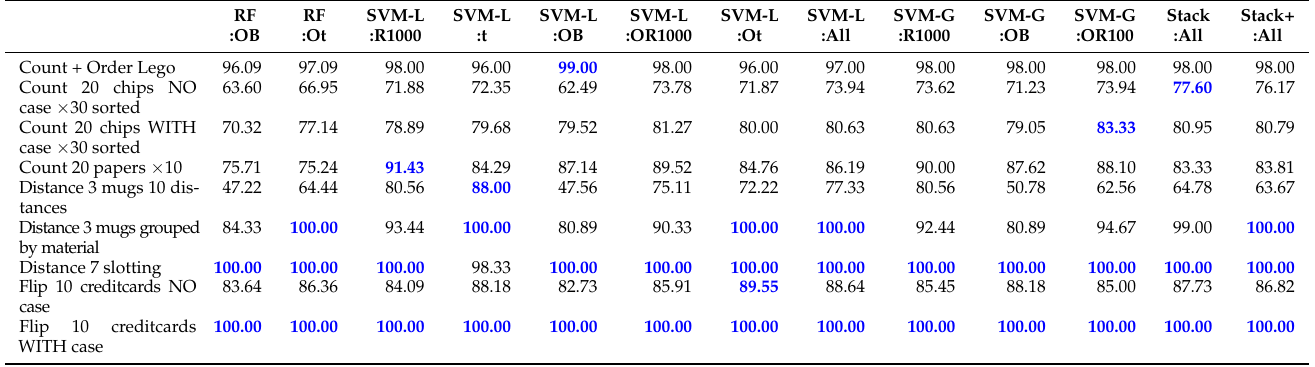
Table 3. Results for a subset of the classifiers with different feature